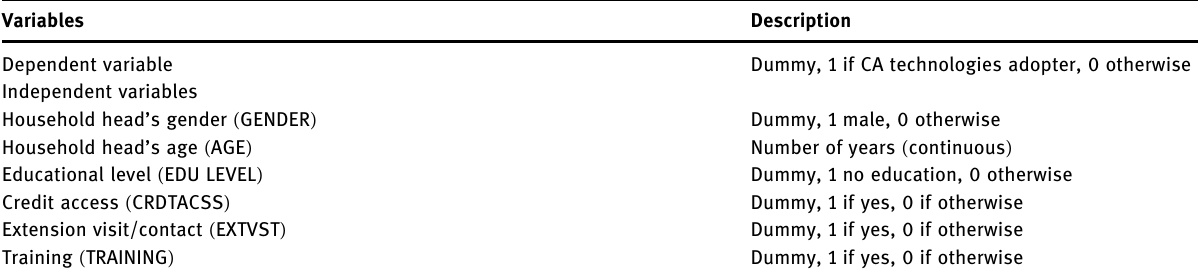
Table 1: Description of variables of factors a ff ecting adoption of CA Variables Description Dependent variable Dummy, 1 if CA technologies adopter, 0 otherwise Independent